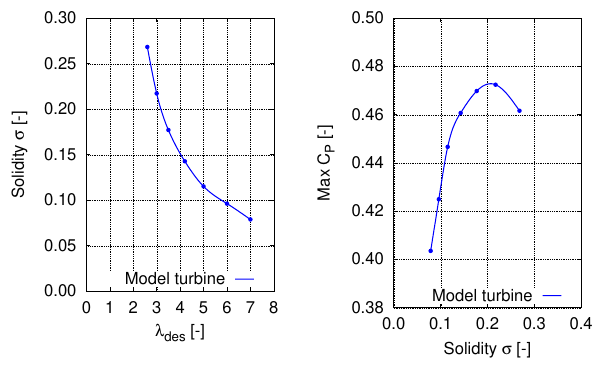
Fig. 20. Model turbine: rotor solidity σ as function of λ des (left), and maximum power coefficient C as function of solidity (right). Pmax